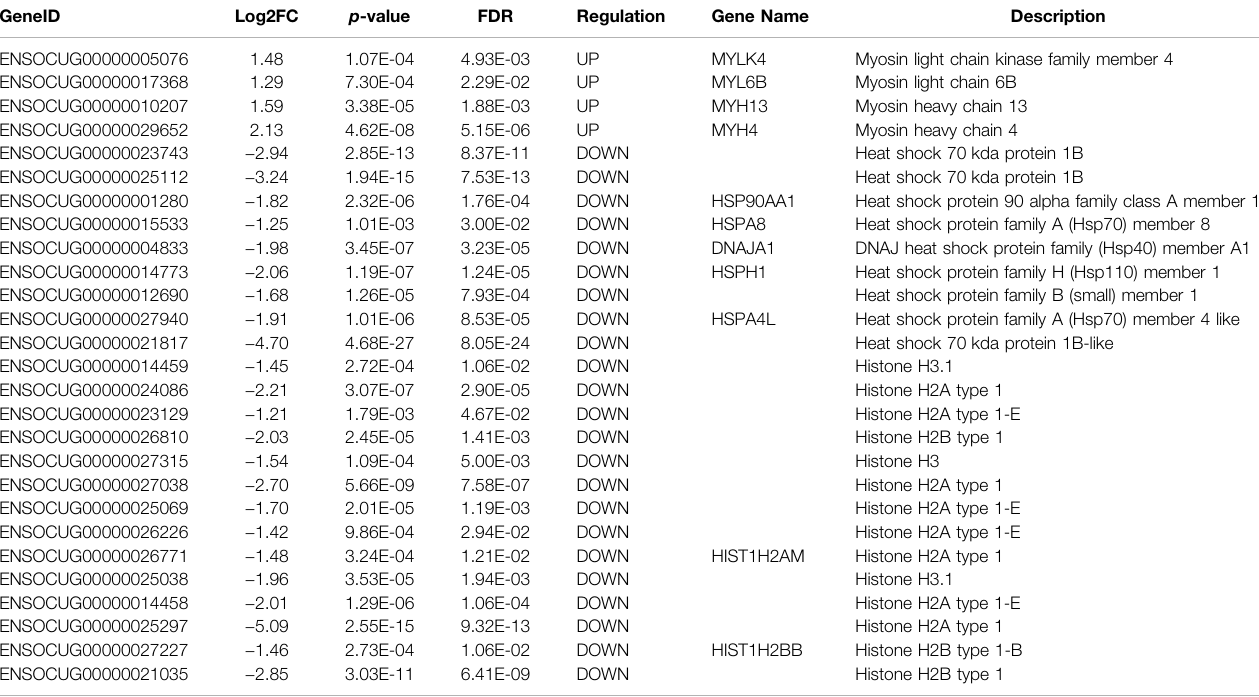
TABLE 1 | Signi fi cant gene groups differentially expressed in the muscle tissues of SCWrabs and ZIKArabs. GeneID Log2FC p -value